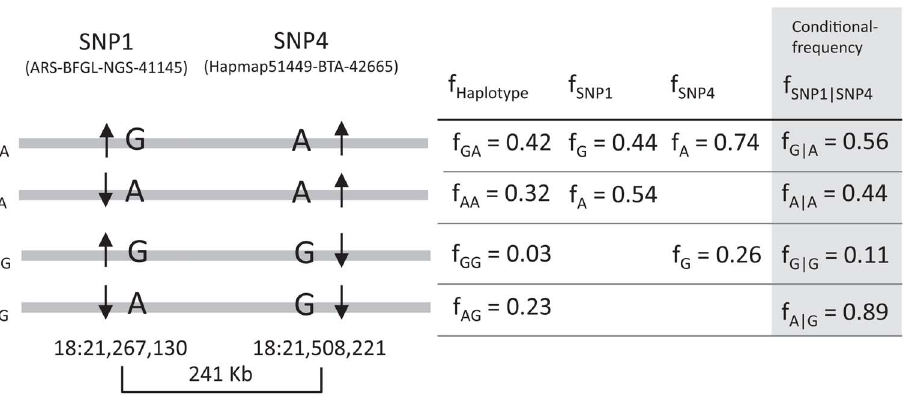
Figure 3. Haplotypes between ARS-BFGL-NGS-41145 (SNP1) and Hapmap51449-BTA-42665 (SNP4). Both SNPs are associated with milk fat yield, but occur with different allele frequency distributions and direction of effect. D’ for the linkage between the two SNPs is 0.759. Frequencies of observed haplotypes as well as total and conditional allele frequencies of SNP1 and SNP4 are given. Arrows indicate the direction of effect on milk fat yield.